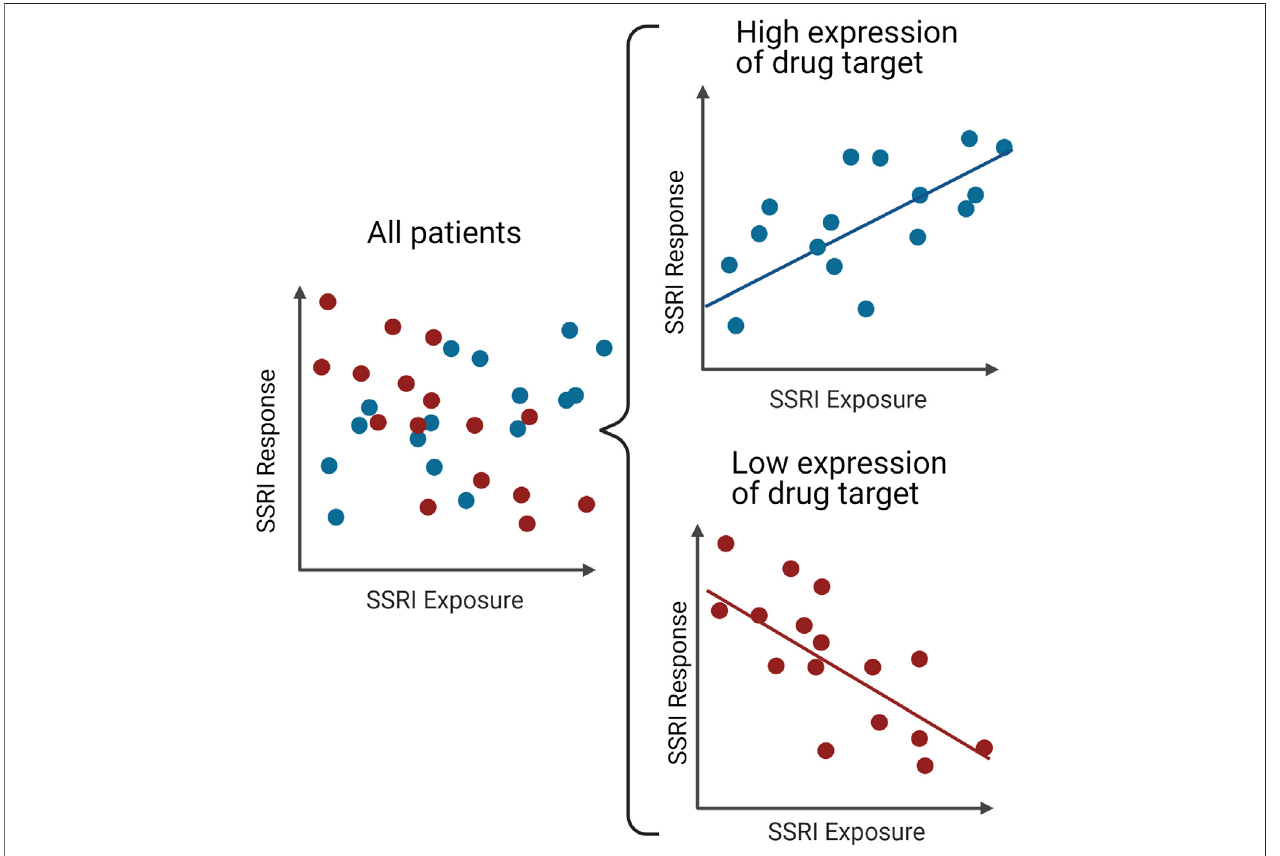
FIGURE 3 | Pharmacodynamic confounding of the SSRI exposure-response relationship. In a combined sample of SSRI treated patients (left), there does not appear tobearelationship between SSRI response and exposure. However, whenpatientsareexaminedseparately,based onapharmacogenetic variantthat impacts pharmacodynamics (e.g., SLC6A4 ), some patients have a positive relationship between response and SSRI exposure whereas other patients — such as those with low expression of the drug target — have a negative correlation between response and SSRI exposure, as per the example in the text of paroxetine and SLC6A4 .